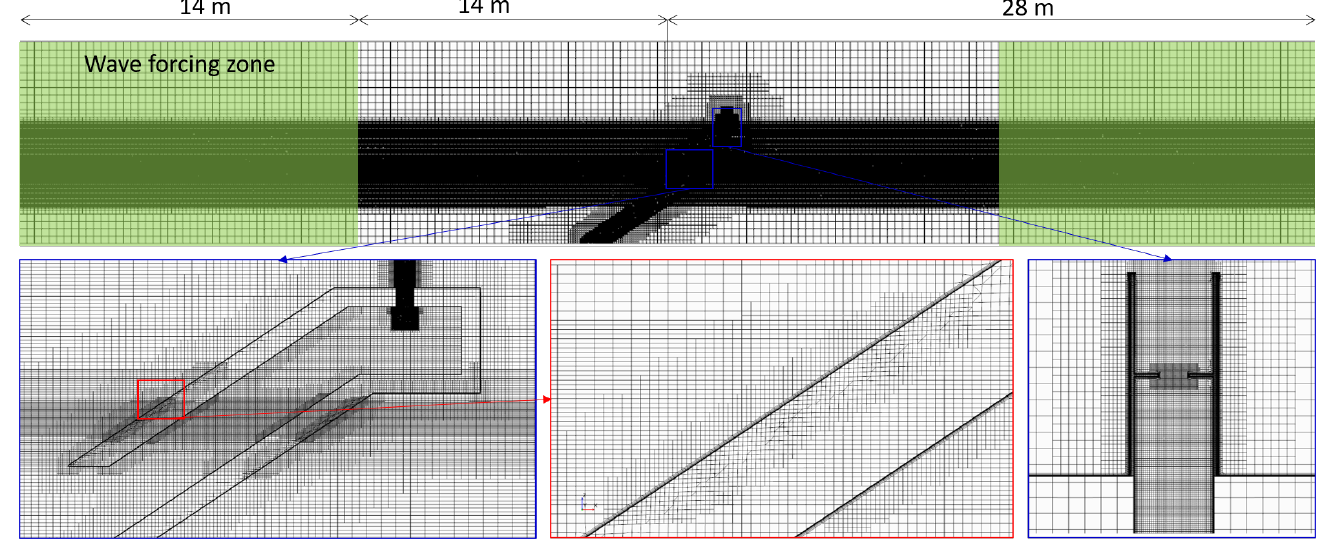
Figure 17. STAR-CCM+ computational domain and grid refinement regions for the wave regimes, the duct, and the